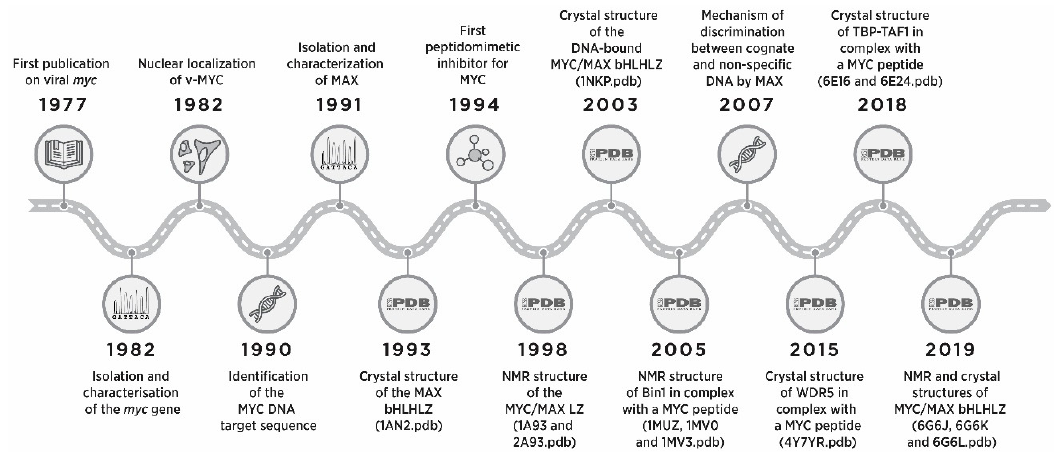
Figure 1. Timeline highlighting relevant achievements related to MYC biology, pharmacology and biophysics.